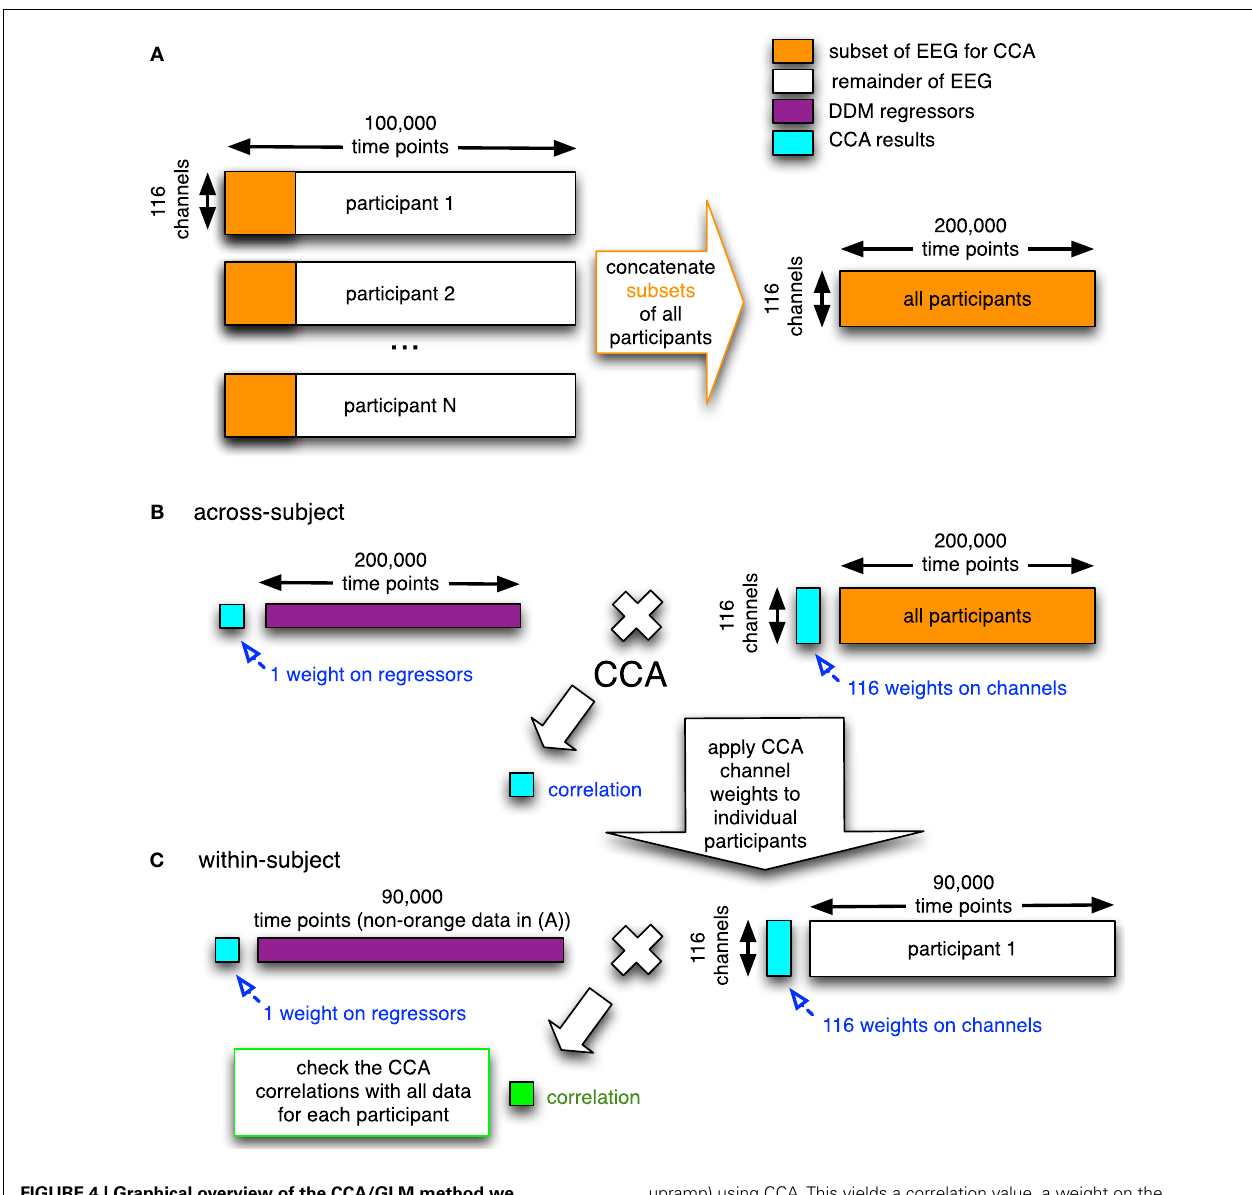
FIGURE 4 | Graphical overview of the CCA/GLM method we developed. In the first step (A) , the electrodes-by-time matrices are concatenated in the time dimension for all participants, where only a subset of the data of each participant is used (orange rectangles).This concatenated matrix with EEG data is then used together with the corresponding concatenation of regressors (purple; the DDM-inspired model time series) in the second step. (B) In this second step, the electrode-by-time matrix that contains data from all participants is correlated with the corresponding time course of the regressor (e.g.,